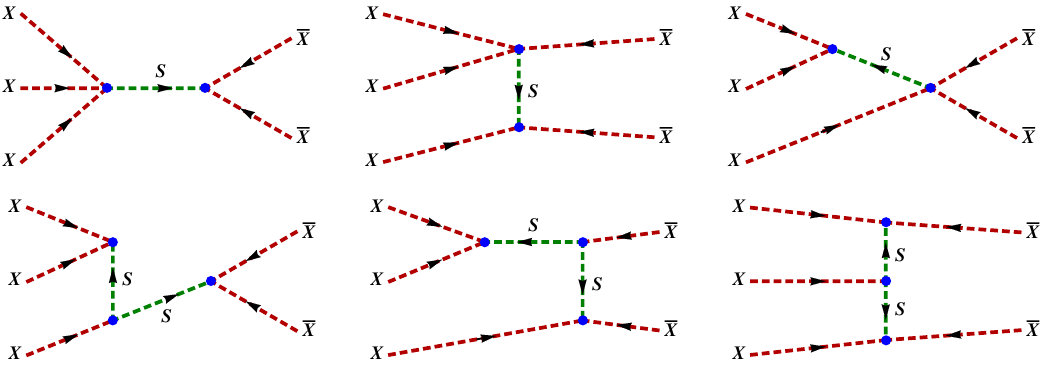
Figure 3 . Feynman diagrams for the 3 ! 2 annihilation process XXX ! (cid:22) X (cid:22) X , where the similar diagrams obtained by crossing the contraction in the initial and the (cid:12)nal states are not shown. where x = m =T , ^ h denotes the normalized Hubble constant, g X